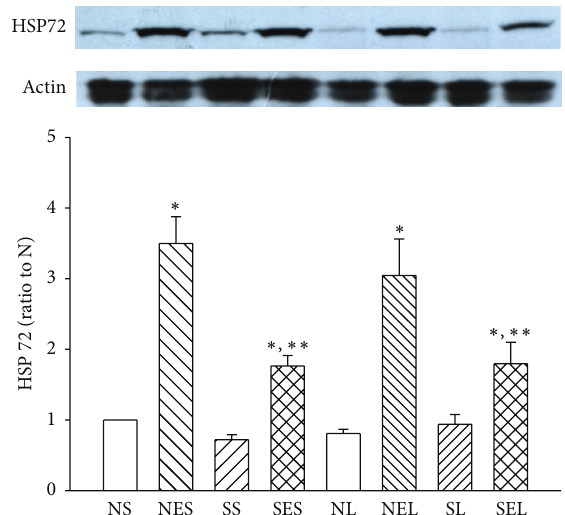
Figure 8: The expression of HSP72 in lungs in the rats with or without exercise after saline or LPS administration. NS: nondiabetic ratsinjectedwithsaline;NES:nondiabeticratswithexerciseinjected with saline; SS: STZ-induced diabetic rats injected with saline; SES: STZ-induced diabetic rats with exercise injected with saline; NL: nondiabetic rats injected with LPS; NEL: nondiabetic rats with exercise injected with LPS; SL: STZ-induced diabetic rats injected with LPS; SEL: STZ-induced diabetic rats with exercise injected with LPS. Data are expressed as the mean ± SEM of eight rats per group. Protein levels are expressed as a ratio to the NS group. Below each column is a representative Western blot of HSP72 protein. Data are expressed as the mean ± SEM of eight rats per group. ∗ 𝑃 < 0.05 , compared with the N group; ∗∗ 𝑃 < 0.05 , compared with NE group (one-way